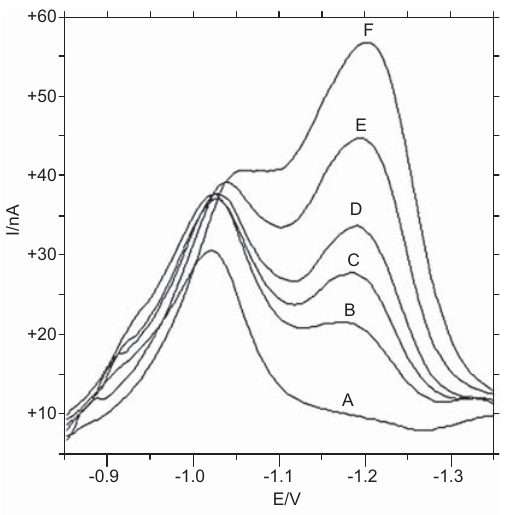
Figure 10 Effect of concentration on the peak current of EZE with the DPAdSV method (A) supporting electrolyte; (B) 66.00, (C) 115.00, (D) 148.00, (E) 212.00, (F) 400.00 ng/ml EZE (accumula- tion time of 15 s, accumulation potential of -0.85 mV, scan rate of 20 mV/s, amplitude of 50